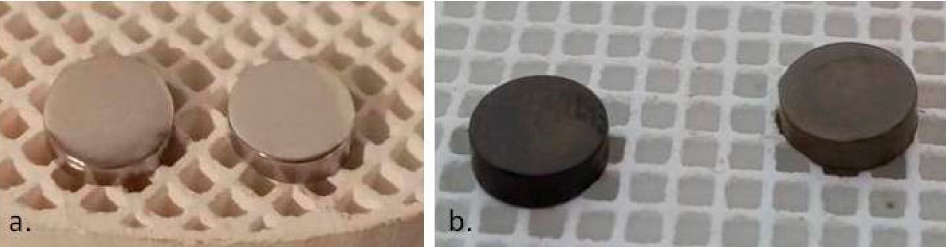
Figure 1. ( a ) Mechanically processed samples to the mirror texture; ( b ) Samples after application of oxidative heat treatment (5-O3 and